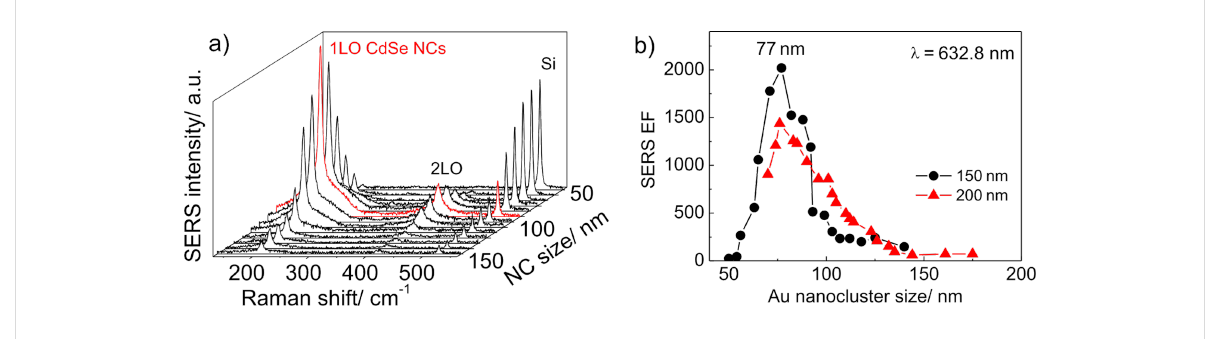
Figure 3: (a) SERS spectra of a single monolayer of CdSe NCs deposited on the nanocluster arrays with decreasing Au nanocluster size. (b) The SERS EF of LO phonon modes in CdSe NCs as a function of Au nanocluster size for Au nanocluster arrays with a pitch of 150 and 200 nm.